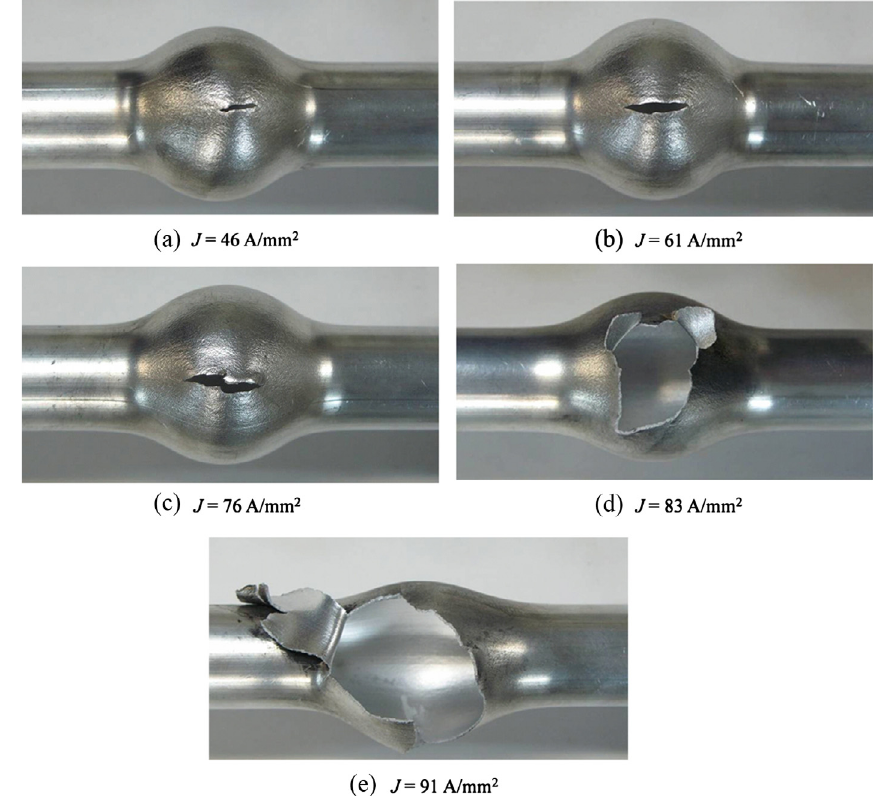
Figure 8. Burst tubes for difference current densities for p 0 = 0.8 MPa.